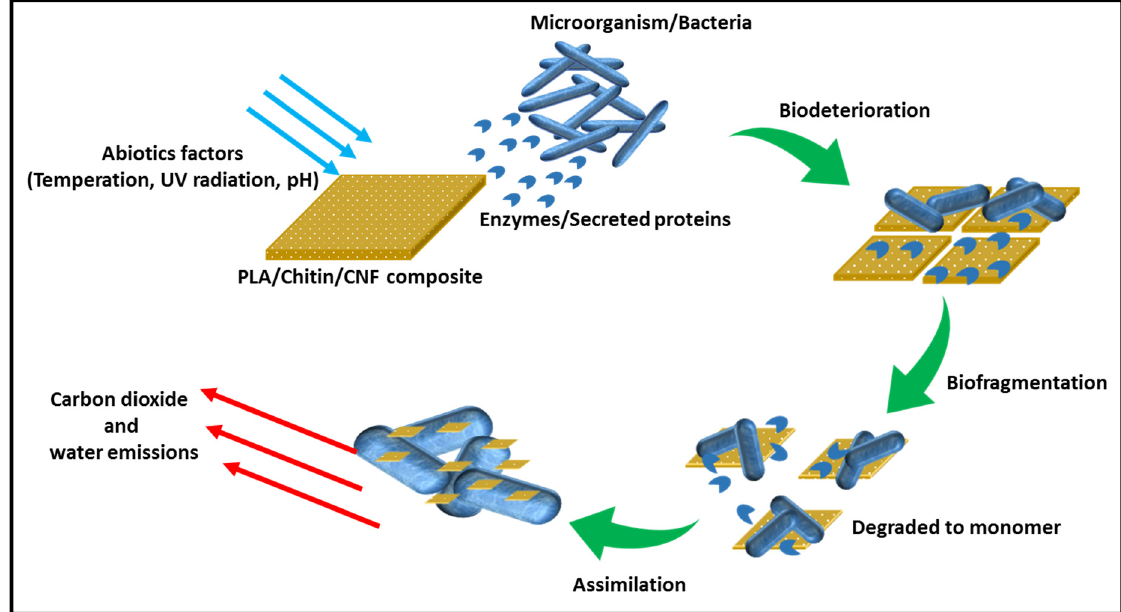
Figure 3. Schematic diagram of molecular enzymatic degradation process in soil burial test.